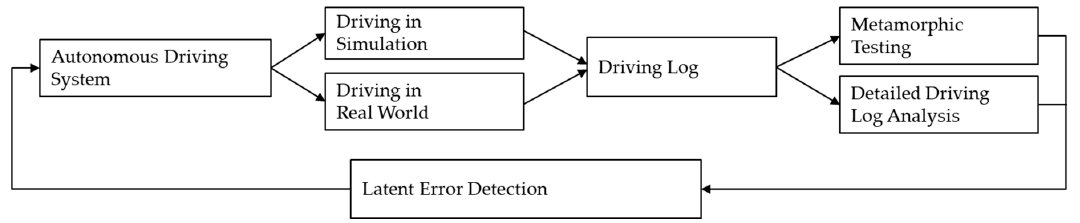
Figure 9. Test sequence of an autonomous driving system.